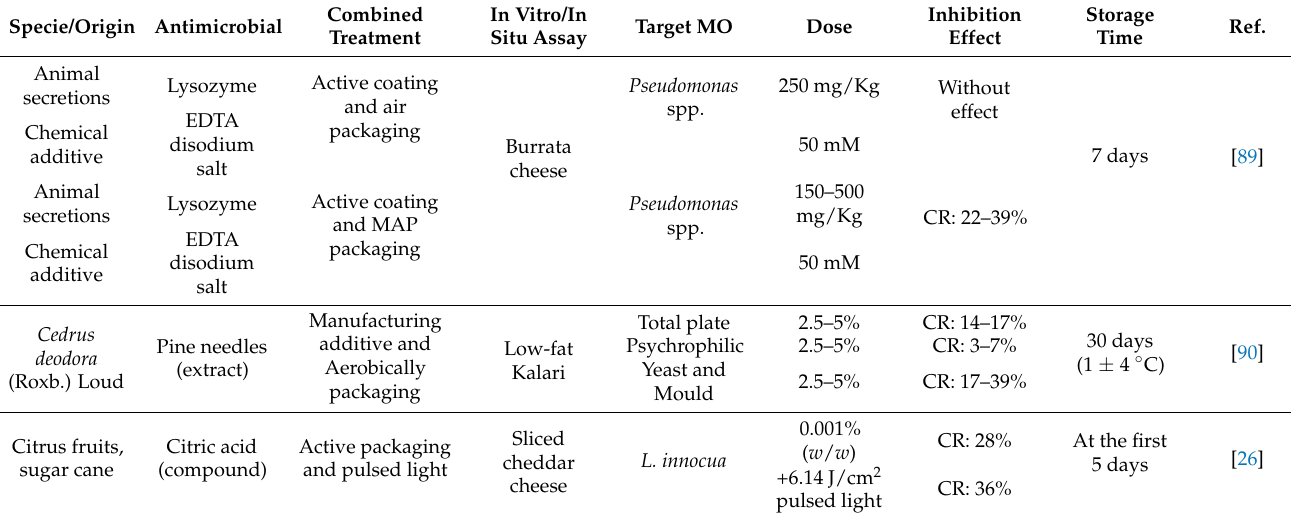
Table 5. Combined treatments for extending the shelf life of cheese as a green alternative to traditional additives: antimicro- bial agents, processing technology, and packaging